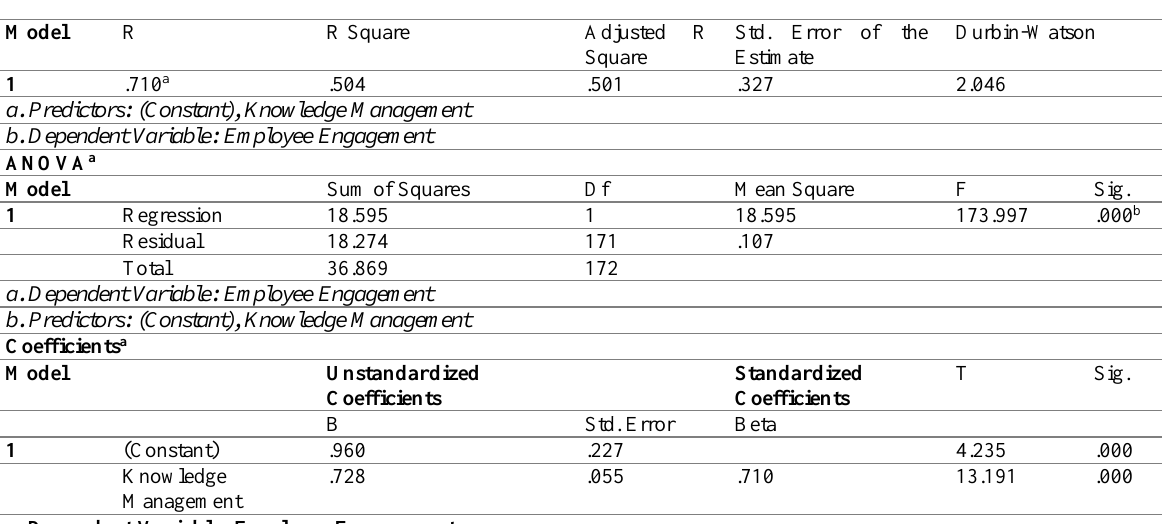
Table 2: Effect of Knowledge Management on Employee